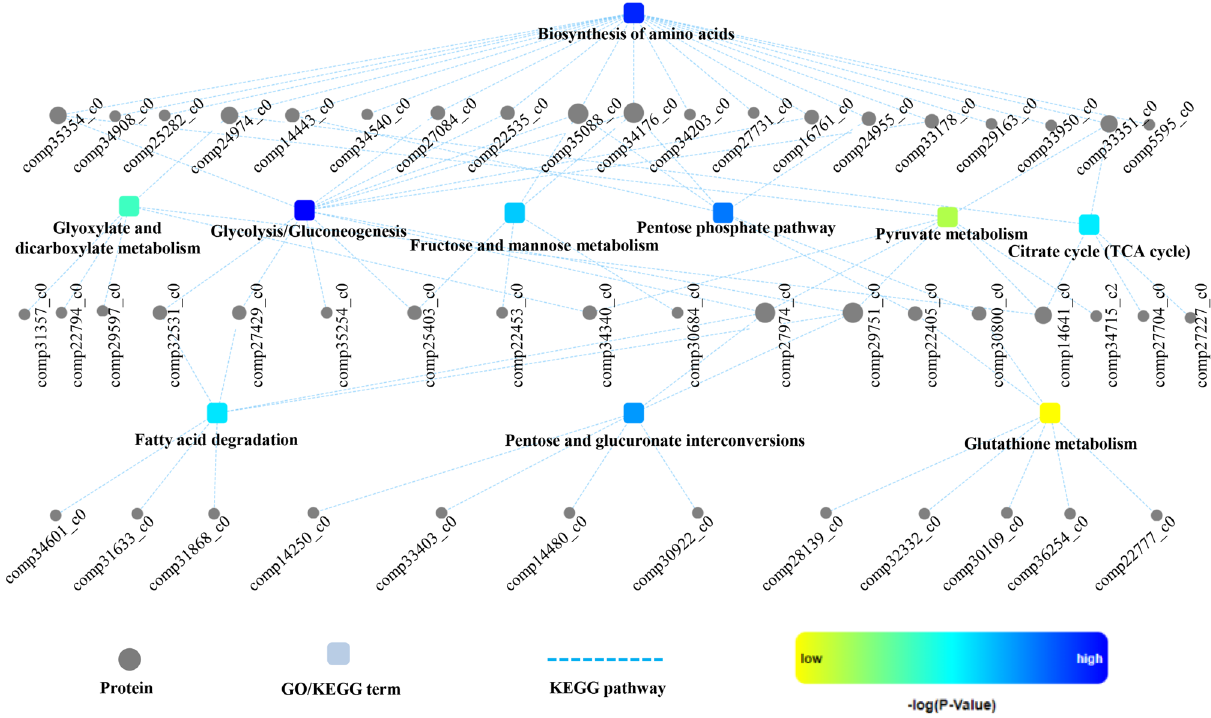
Figure 4. Protein–protein interaction networks of acetyl proteins of P.